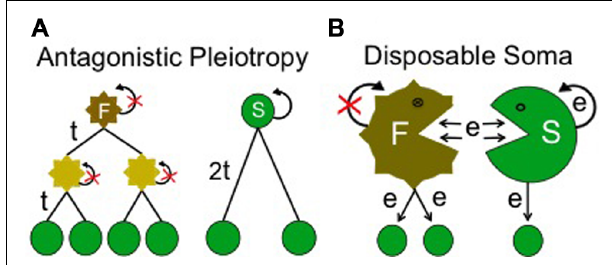
FIGURE 3 | Secondary aging theories. This class of evolutionary aging theory assumes that a continuous trade-off restricts selection for longer lifespan. (A) Example representing “Antagonistic Pleiotropy” where selection for longevity is assumed to be restricted due to the pressure for faster reproduction. Here a fitter individual (F) is able to produce two offspring with generation time, t. After 2t, individual F has four descendents. In this case, fast reproduction is supposed to cause a side effect on body homeostasis (shown by jagged edges and non-green color) and to minimize regeneration (curly arrow with red cross). A more slowly reproducing individual (S), although more able to regenerate and limit deterioration, is unable to compete under these conditions, as it produces only two descendents in 2t. (B) Example representing “Disposable Soma” where selection for longevity is assumed to be restricted due to optimized, efficient utilization of energy (e) for reproduction. Here the fitter individual (F) uses more of the energy consumed to produce offspring rather than regenerate its own body. As a result it deteriorates faster but produces more offspring than an individual (S) which uses more energy for